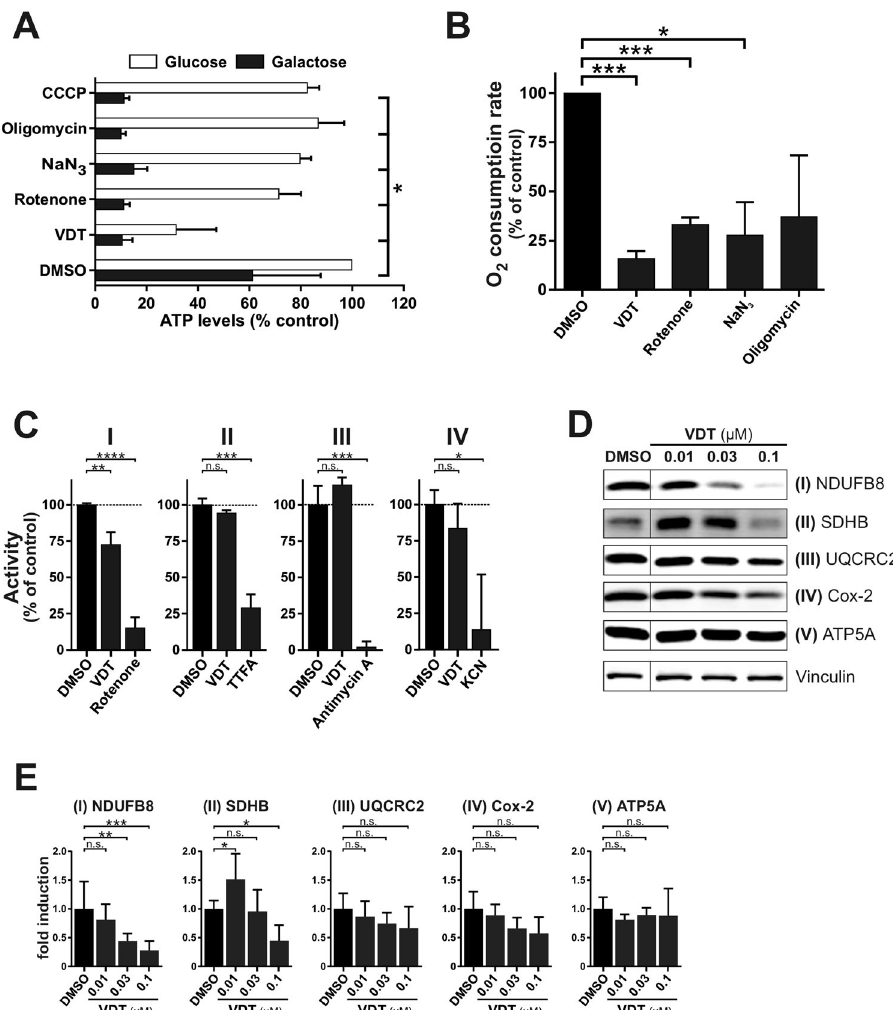
Fig. 6 VDT impairs mitochondrial respiration. A Measurement of the effect of VDT (10 µM) and a selection of known mitotoxins on the ATP levels of Ramos cells. Ramos cells were treated for 90 min with the indicated agents in full growth medium containing either glucose or galactose as the only available sugar. Galactose alone forces the cells to rely entirely on OXPHOS for ATP synthesis. The following complex- speci fi c inhibitors of the respiratory chain were used: rotenone (complex I; 10 µM), sodium azide (NaN 3 , 1 mM; complex IV), oligomycin A (complex V; 10 µM). Subsequently, the ATP levels were measured using the luminescence-based mitochondrial ToxGlo ™ assay (Promega). The depicted values were normalized to cells treated with DMSO (0.1% v/v) in glucose containing growth medium (set to 100%). Error bars = SD of three independent experiments performed in triplicates; p -values were calculated by two-way ANOVA with the Holm – Sidak post-test; * p ≤ 0.05. B Comparative measurement of the oxygen consumption rate of Ramos cells treated with VDT (10 µM) or a range of known complex-speci fi c inhibitors of the respiratory chain (see Fig. 6A) using the MITO-ID ® Extracellular O 2 Sensor Kit (High Sensitivity; Enzo). The oxygen consumption rate of cells treated with 0.1% DMSO (v/v) was set to 100%. Error bars = SD of three independent experiments performed in triplicates; p -values were calculated by one sample t -test; * p ≤ 0.05, *** p ≤ 0.001. C The activities of the individual complexes of the respiratory chain were measured after treatment with VDT (10 µM) or respective complex inhibitors [complex I: 10 µM rotenone;